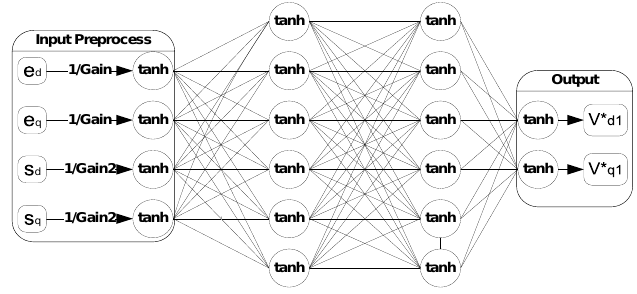
Figure 4. NN current-loop controller